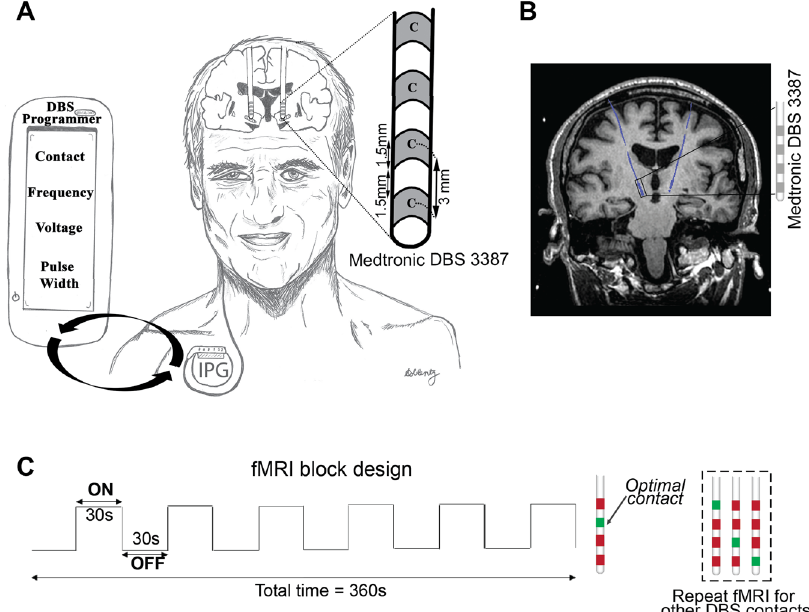
Fig. 1 Experimental design of 3 T fMRI imaging with DBS activation in PD patients. A DBS patient implanted with bilateral fully internalized and active DBS electrodes targeting the STN. The DBS lead (Medtronic 3387) has four contacts (width = 1·5 mm) spaced 1.5 mm apart. Using the handheld DBS programmer, DBS programming involves titrating the current delivered by adjusting multiple parameters (i.e., electrode contact, voltage, frequency, and pulse-width) in order to provide the best symptom relief. B Coronal T1-weighted image demonstrating a PD patient with fully internalized and active DBS electrodes (blue) implanted in the STN. C fMRI block design paradigm used during 3 T fMRI data acquisition. While the patient laid still in the scanner, unilateral (left) DBS stimulation was cycled ON and OFF every 30 s for six cycles. The DBS ON/OFF cycling was manually synchronized to fMRI acquisition. Each fMRI sequence was acquired at either optimal (green) or non-optimal (red) contacts or voltages. In this example, the four contacts were screened with fMRI; the a priori clinically optimal contact (marked in green) and non-optimal contacts (marked in red) are shown. DBS deep brain stimulation, fMRI functional magnetic resonance imaging, PD Parkinson ’ s